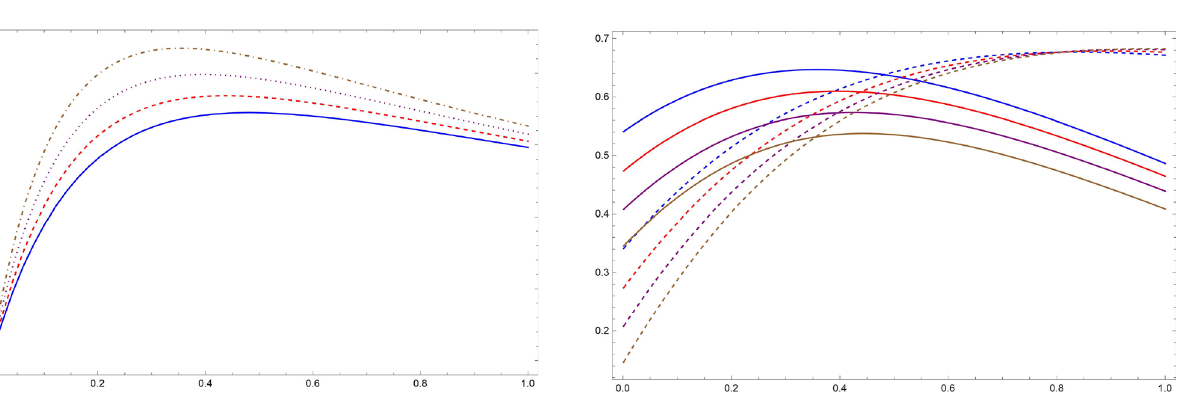
Fig. 6 ˜ P r / ˜ P rc (left) and ˜ ρ/ ˜ ρ c (right) vs x for y = 0 . 40 , u (cid:5) = 1 . 10 solid (blue) curve, u (cid:5) = 1 . 20 dashed (red) curve, u (cid:5) = 1 . 30 dotted (purple) curve and u (cid:5) = 1 . 40 dot-dashed (brown) curve. Second case with vanishing complexity using F-S as seed